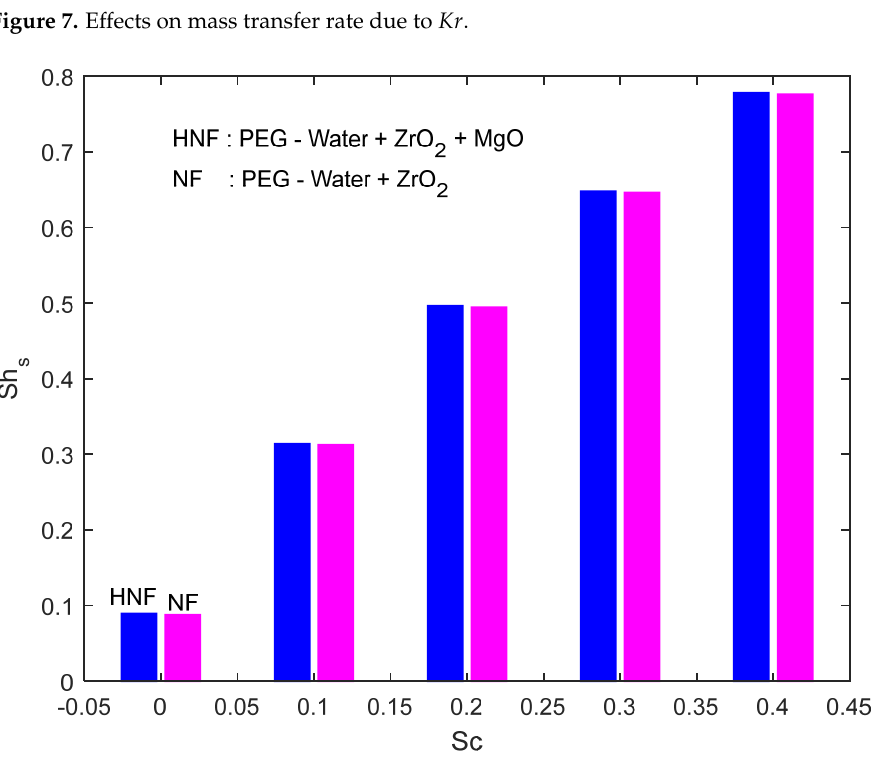
Figure 8. Effects on mass transfer rate due to Sc .